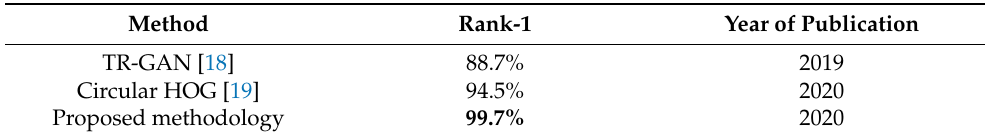
Table 4. Results produced through the proposed methodology when compared with the state-of-the- art for the tufts